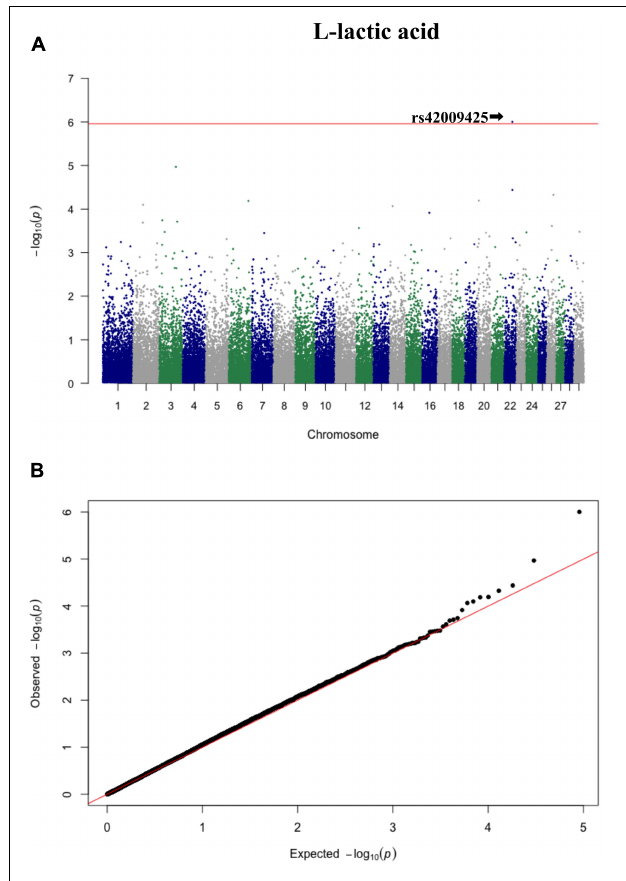
FIGURE 4 | Manhattan plot (A) and QQ plot (B) for L -lactic acid, significant SNPs were determined by Bonferroni correction (red line).